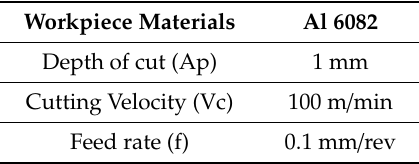
Figure 3. A rhombic 80° turning insert: ( a ) The actual insert and ( b ) side view of the geometry of the chamfer. (Dimensions in mm). chamfer. (Dimensions in